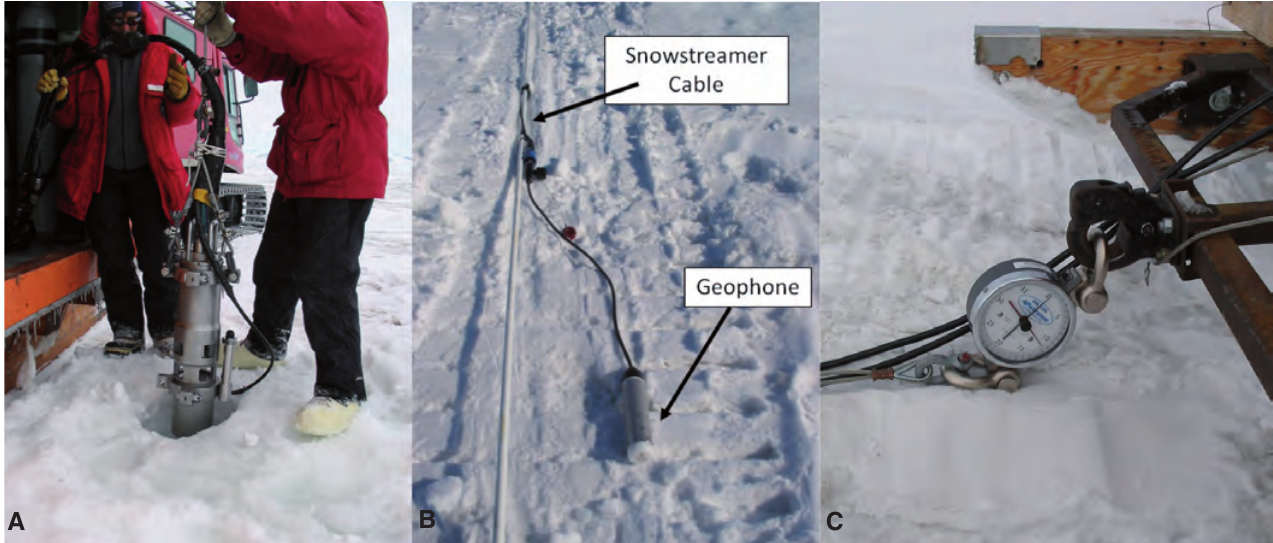
Figure 3. [A] Generator-Injector (GI) air gun being deployed through an auger hole in 6-m-thick sea ice; [B] Gimbaled geophone and the snow streamer cable; [C] Load cell attached to the back of the Thunder Sled and connected to a tow cable for the snow streamer (photos by R.